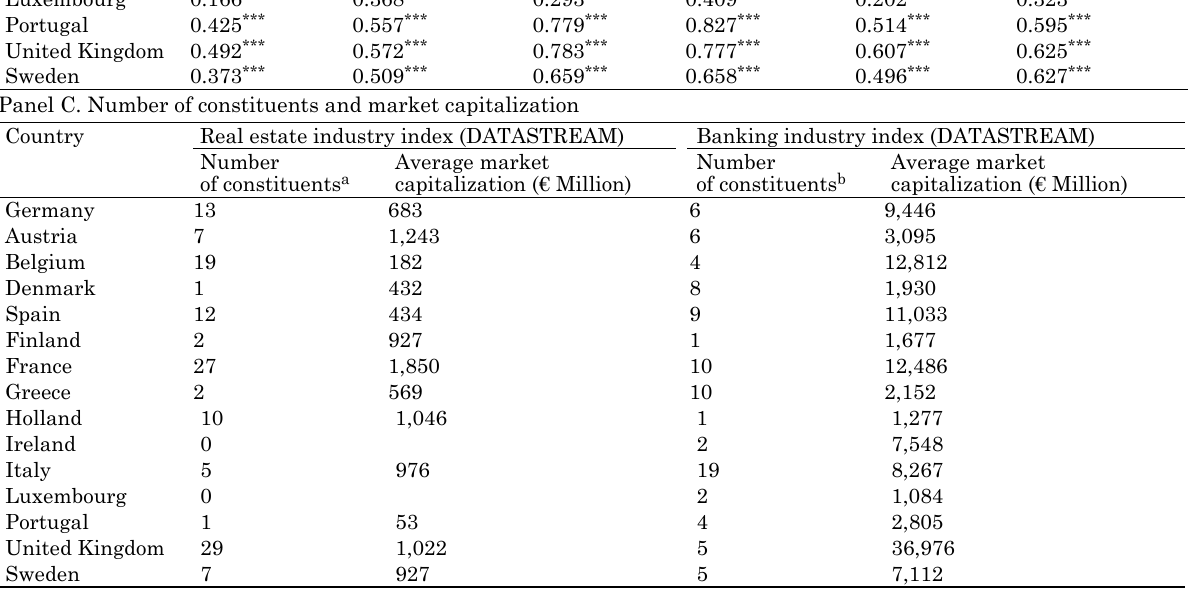
Panel B. Correlation of index returns Country Banking vs. real estate Banking vs. market Real estate vs.